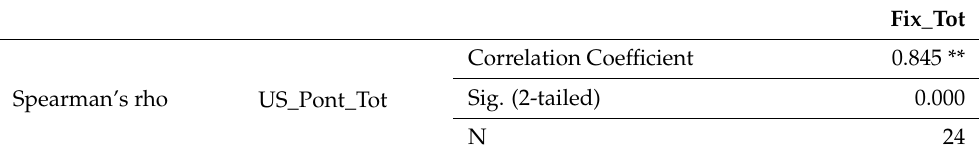
Table 12. Correlations.